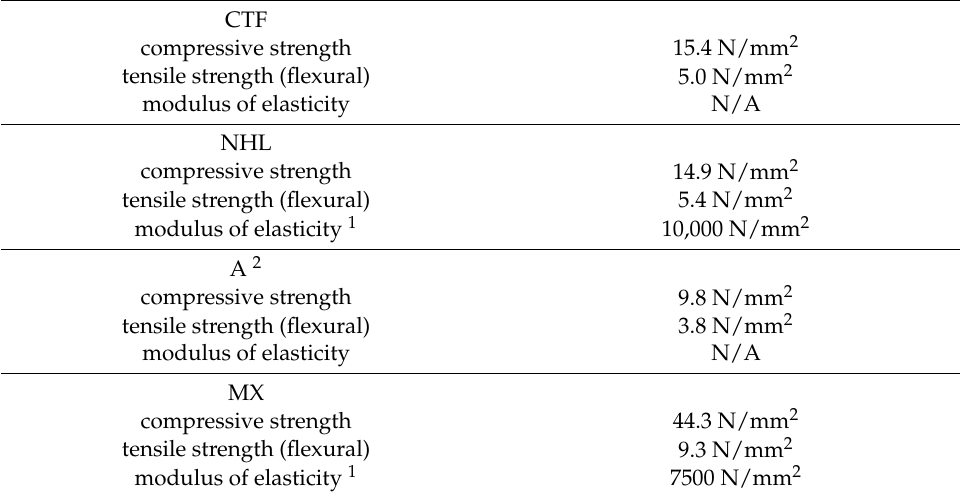
Table 3. Mechanical properties of mortars (matrixes) used in the tests at 28